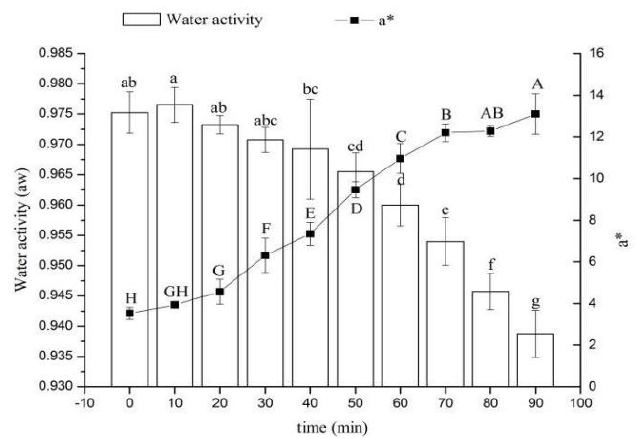
Figure 2. Variation of the water activity and a* during drying. Note: Different uppercase/lowercase letters means differ significantly (p < 0.05).